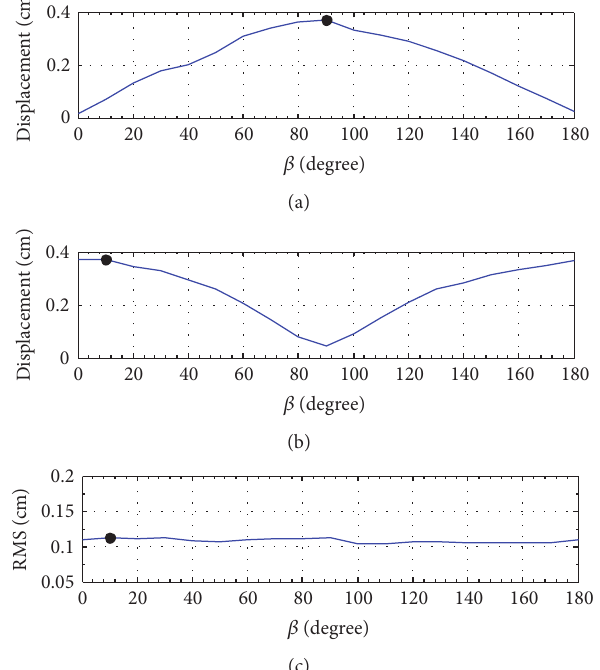
Figure8:Thedisplacementresponseofbuildingmodelversustheangleofloadapplication:(a)theRMSvaluesofdisplacementin x -direction, (b) the RMS values of displacement in y -direction, and (c) the RMS value of the resultant displacement (bullets representing the maximum values).